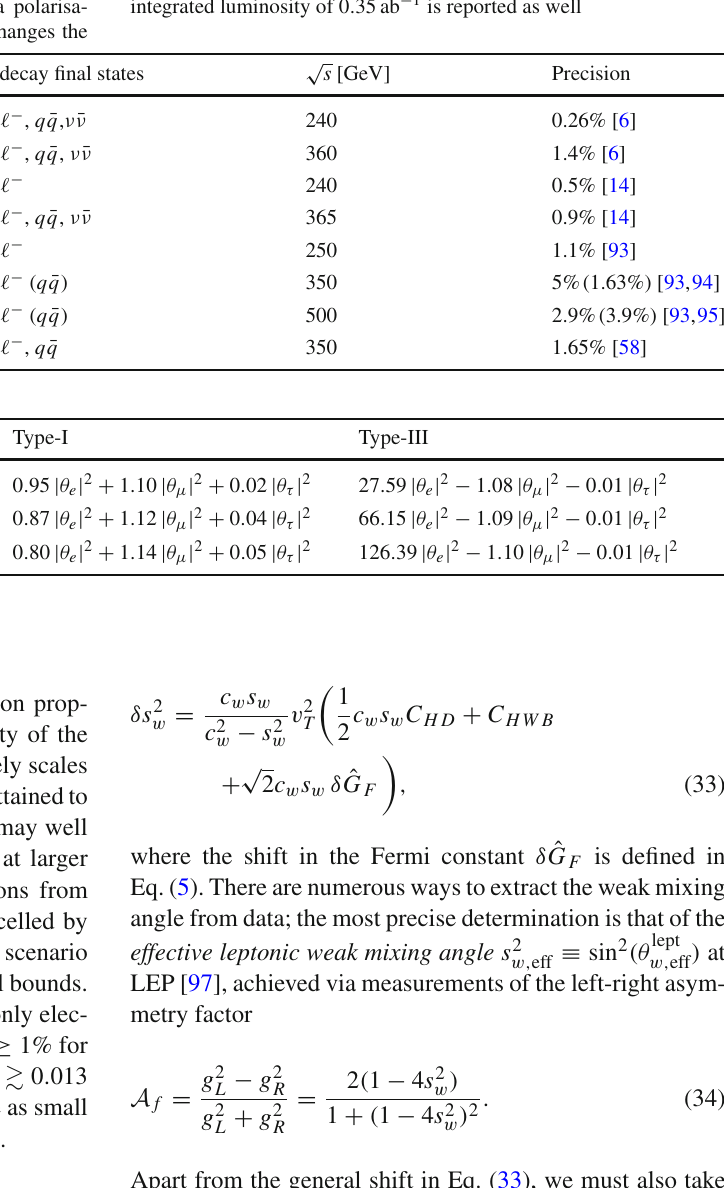
expected Higgsstrahlung event rate by maximally 50% compared to unpolarised beams [58,94]. No polarisation is assumed for the ILC pre- √ s = 350GeV and hadronic Z -boson decays in Ref.[94], cision for wherein an attainable precision of 1.76% for polarised beams and an integrated luminosity of 0 . 35ab − 1 is reported as well